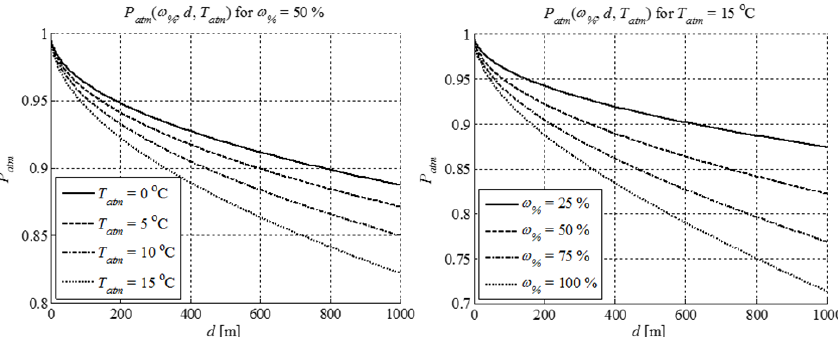
Figure 3. Simulation characteristics of the atmospheric transmittance P atm = f ( d ) vs. camera-to-object distance d for full form of model (Eq. 2) as a function of the (a) temperature of the atmosphere T atm , ω % = 50%, and (b) relative humidity of the atmosphere ω % , T atm = 15 ◦ C.